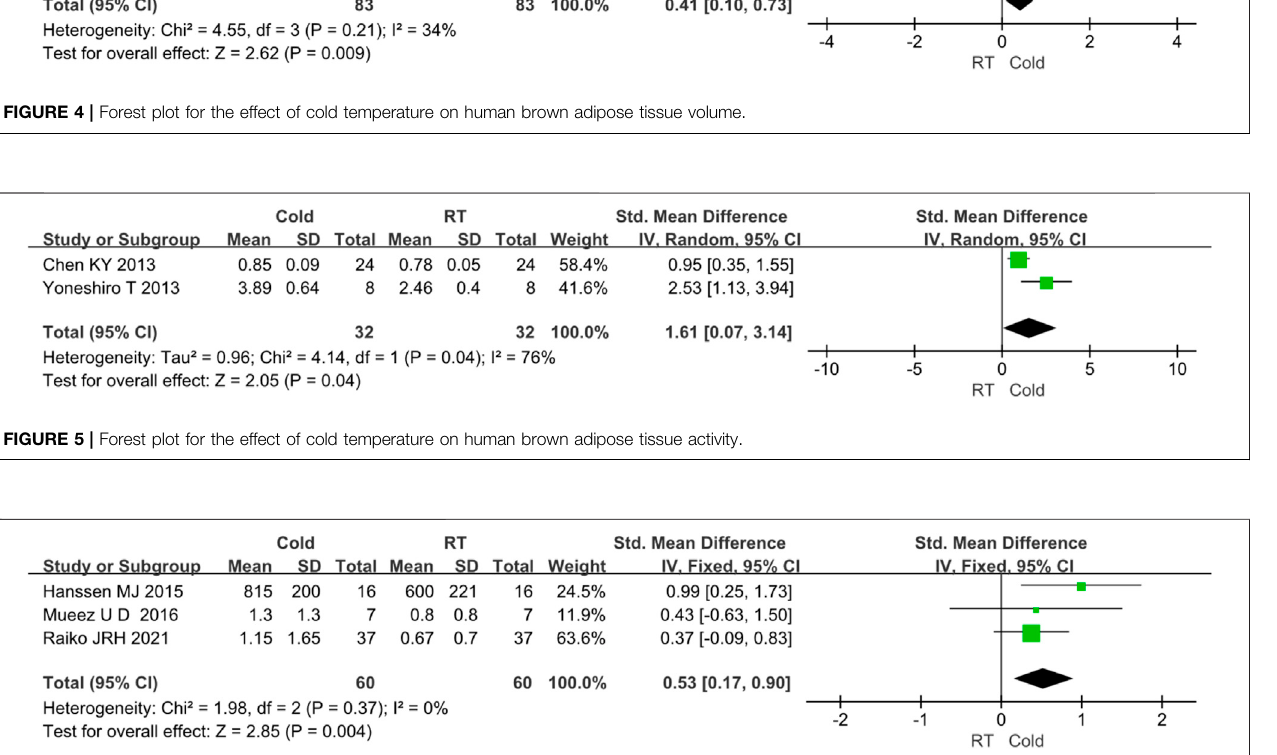
FIGURE 6 | Forest plot for the effect of cold temperature on human brown adipose tissue NEFA uptake.